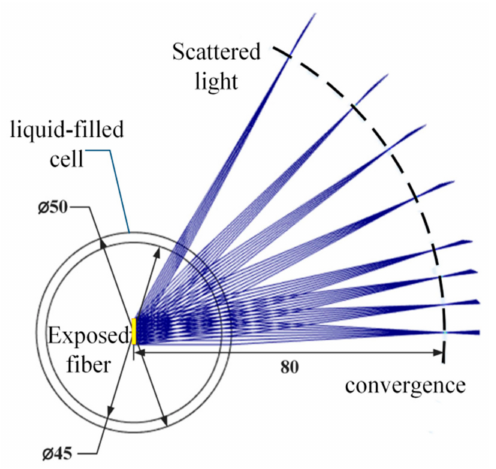
Figure 3. Fiber scattering measurement equipment.